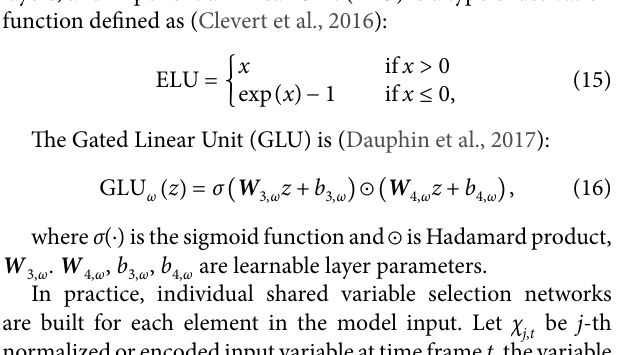
layers, and Exponential Linear Unit (ELU) is a type of